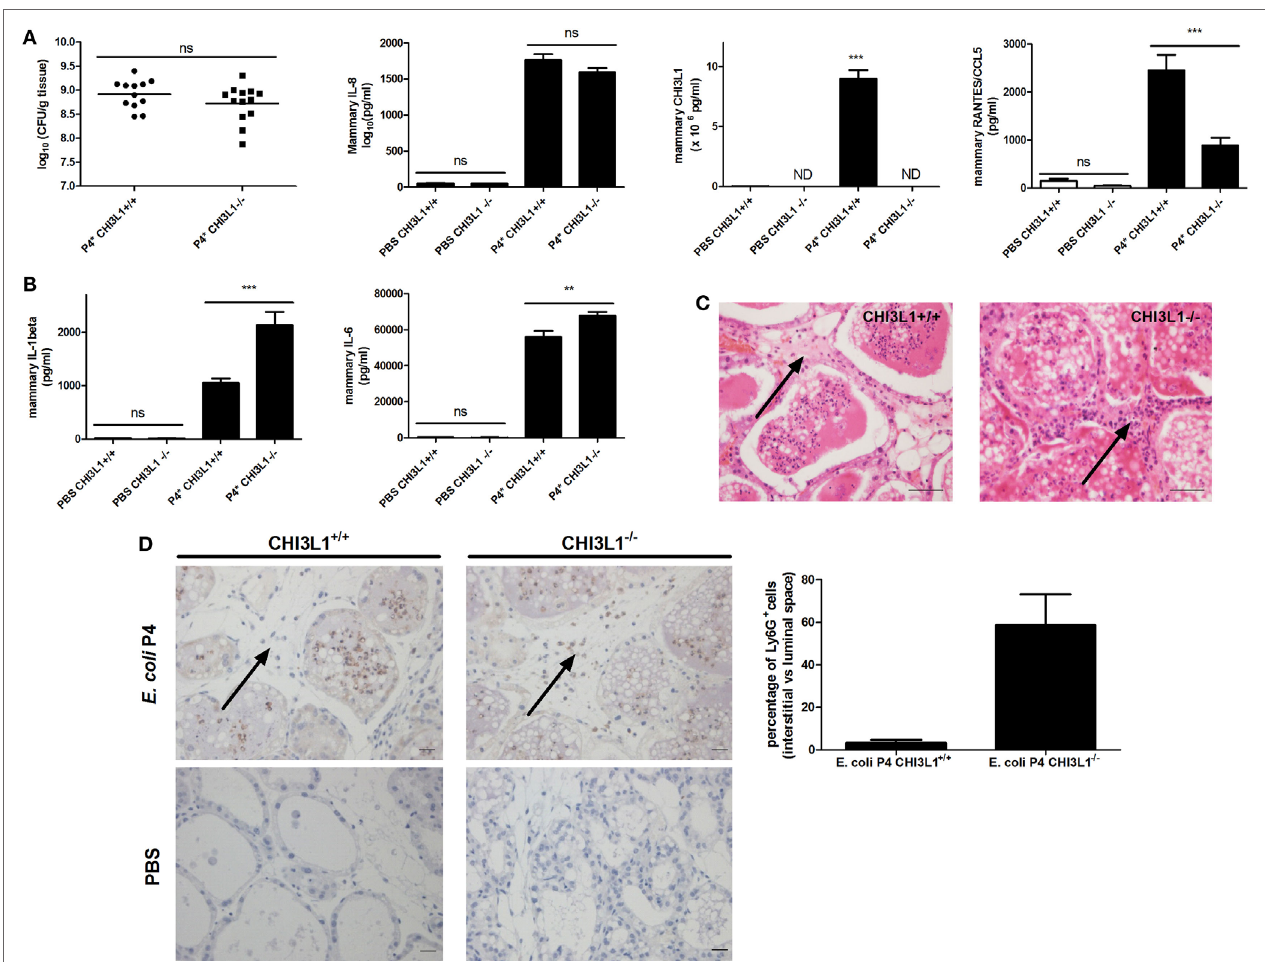
FigUre 3 | Downstream effects of mammary chitinase 3-like 1 (CHI3L1) during Escherichia coli P4 infections in the mouse mastitis model. (a) Bacterial loads (